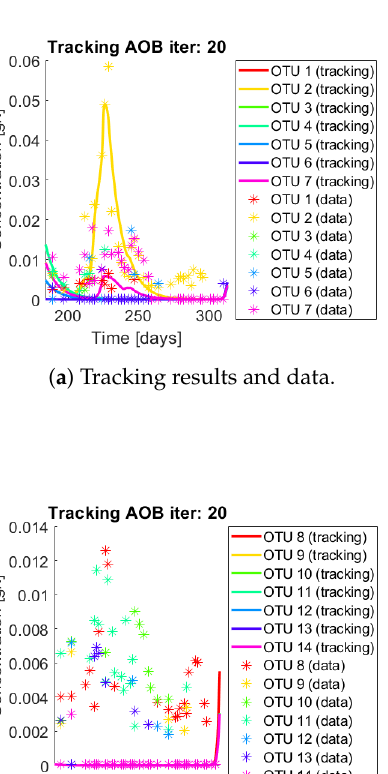
Figure 14. Results on applying the tracking method to a nitrification experiment when all OTU are tracked independently. Data points are represented by a star. The continuous line represents the tracking procedure results.